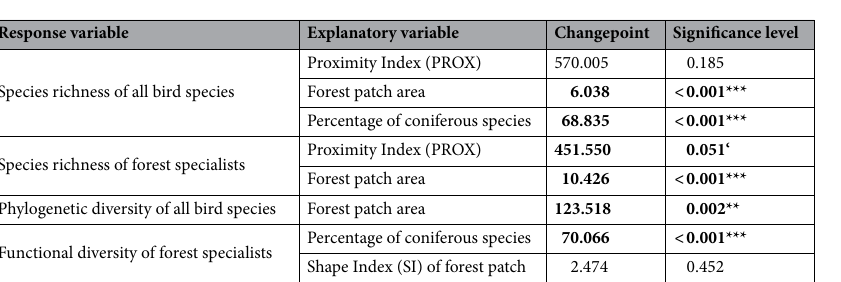
Table 3. The response thresholds of diversity metrics to forest patch size and isolation. Thresholds were calculated only for variables that had statistically significant effect on diversity measures.